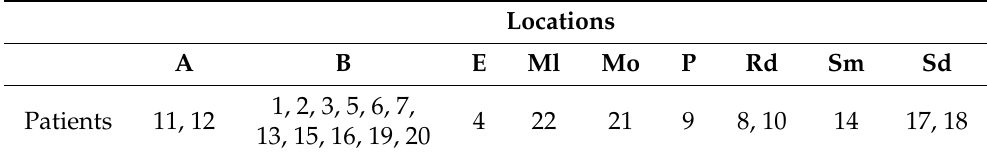
Table 3. Information on each patient’s location.